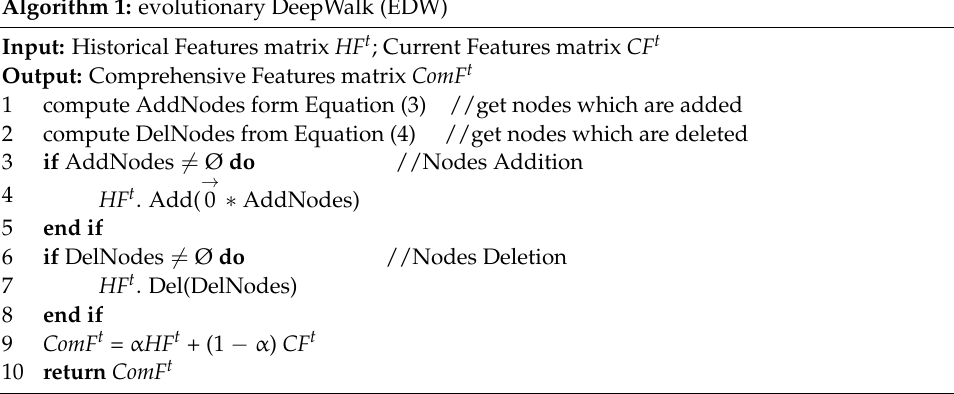
Algorithm 1: evolutionary DeepWalk